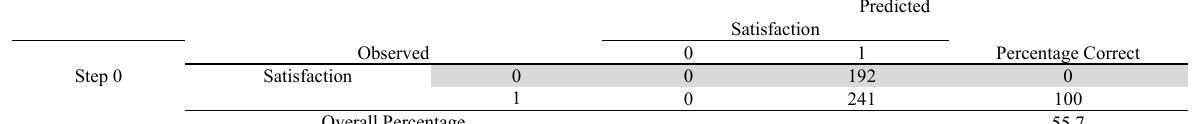
Classification Tables a,b